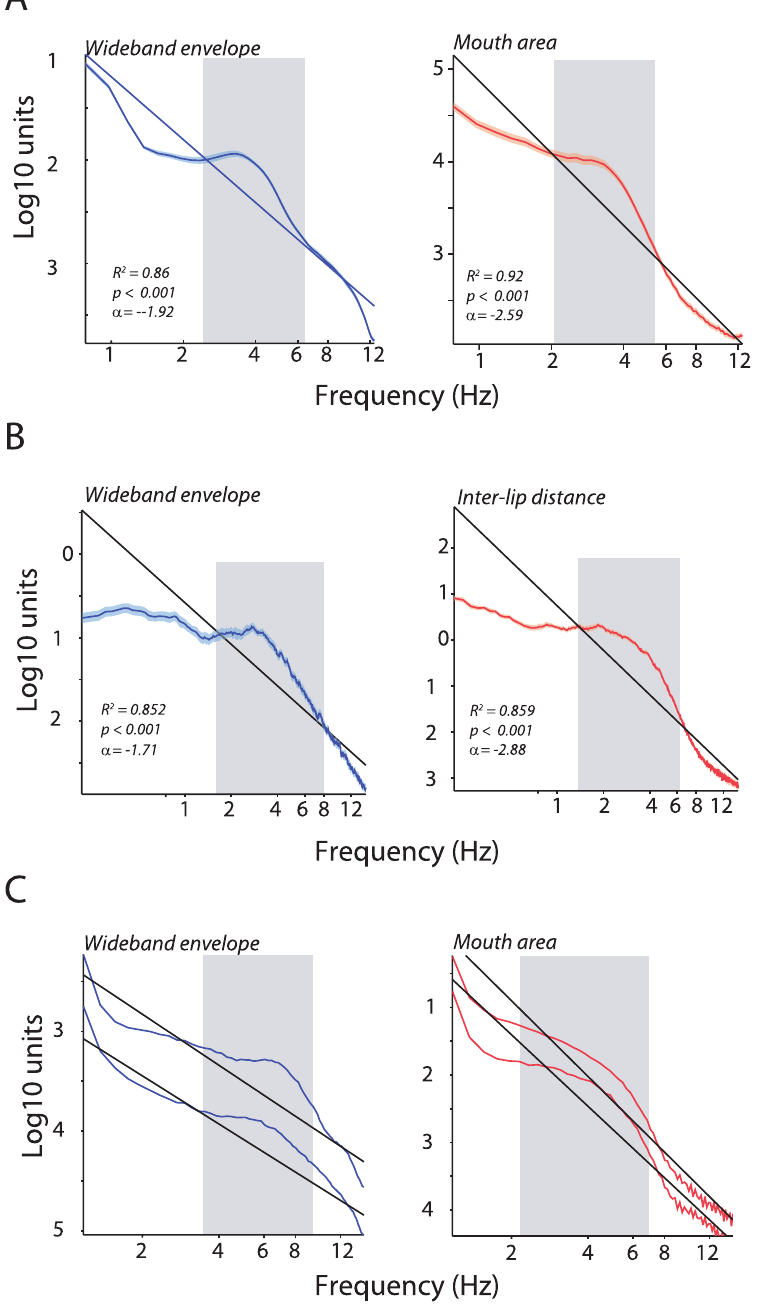
Figure 6. Temporal modulations in the population. A - Left, average multitaper Fourier spectrum of the wideband auditory envelope across all subjects in the GRID corpus plotted on log-log axes. Right, average multitaper Fourier spectrum of the mouth area function across all subjects in the GRID corpus plotted on a log-log axis. Figure conventions as in 5B. Gray shading denotes regions in the 2–7 Hz band, which seem to deviate from the 1/f fit. B - Left, average multitaper Fourier spectrum of the wideband auditory envelope across all subjects in the Wisconsin x-ray database plotted on log-log axes. Right, average multitaper Fourier spectrum of the inter-lip distance across all subjects in the Wisconsin x-ray database plotted on a log- log axis. Figure conventions as in 5B. C - Left, average multitaper Fourier spectrum of the wideband auditory envelope averaged over the entire spontaneous speech segment for the two subjects from the spontaneous speech database plotted on log-log axes. Right, average multitaper Fourier spectrum of the mouth area function for the two subjects in the spontaneous speech database plotted on a log-log axis. Figure conventions as in 5B.